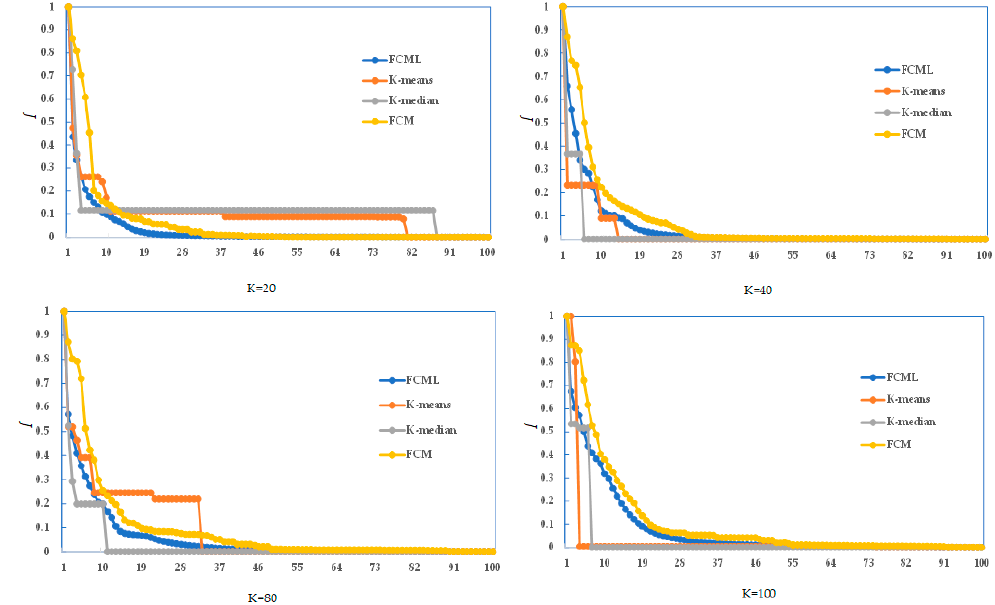
Figure 12. The figures plot the J obtained by the K-means, K-median, FCM, and FCML clustering algorithms, averaged over 20 independence trainings with different cluster numbers (K = 20, 40, 80, 100) on real-world taxi GPS datasets (Beijing, China).